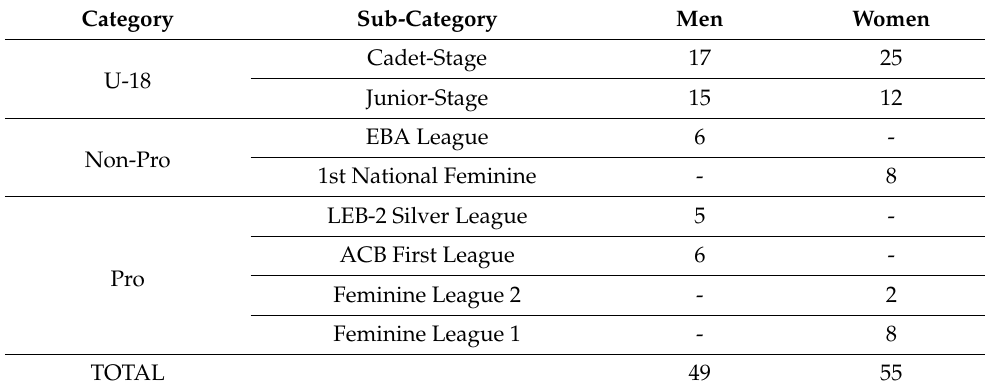
Table 1. Description of the